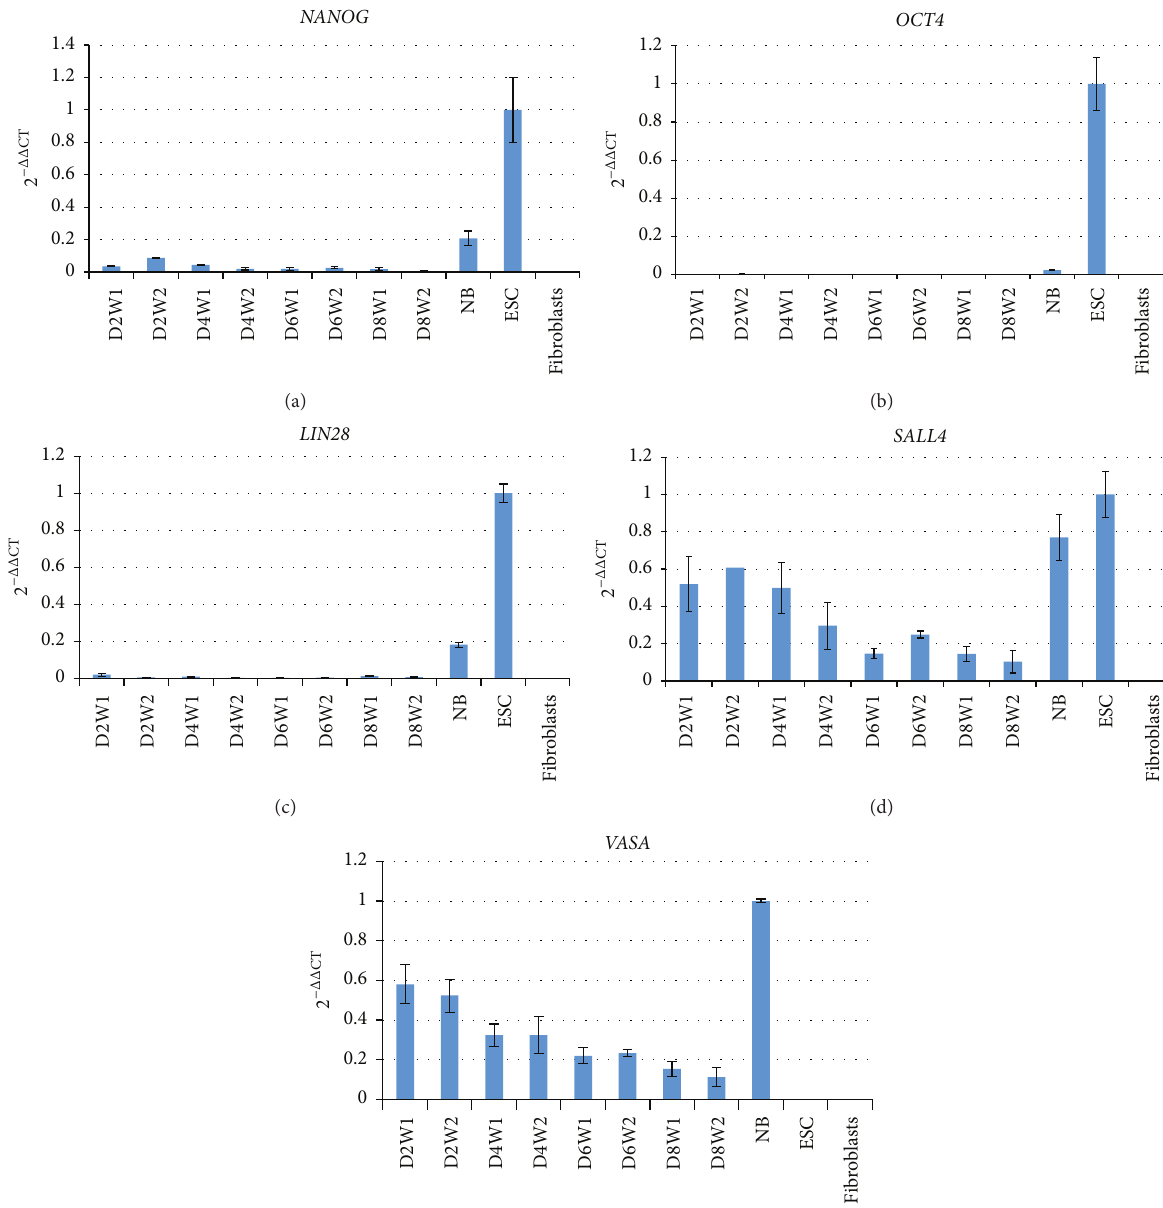
Figure 7: Pluripotency and germ cell marker mRNA abundance during the development of OCCs within one passage as revealed by real-time quantitative PCR. Positive controls for OCT4A , SALL4 , and LIN28 were ES cells. Neonatal ovary was used as positive control for the germ cell marker VASA . NANOG was very low and OCT4A and LIN28 were absent at all time points analyzed. Relative abundance of SALL4 and VASA generally decreased with time during the culture period. D: days of culture. W: well for cell culture. NB: newborn ovary.